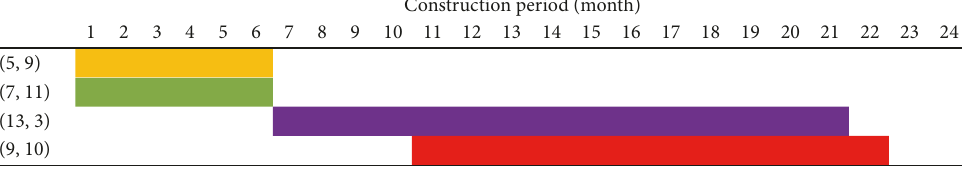
Figure 6: Selection and scheduling results with joint optimization for Scenario 1 .